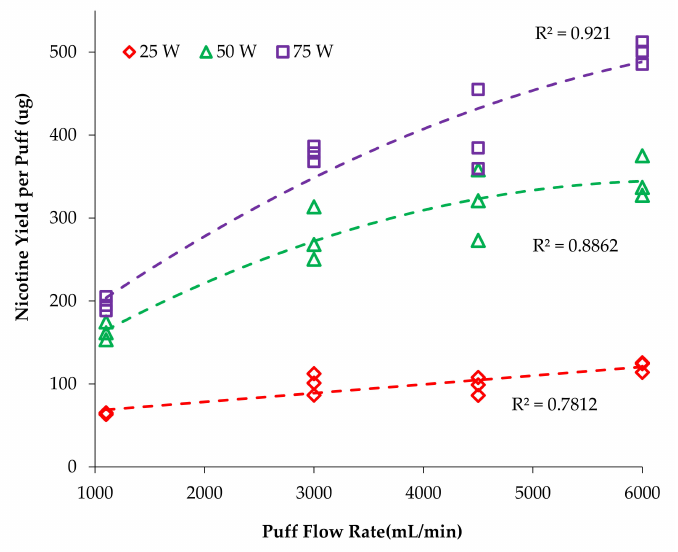
Figure 3. Effect of flow rate on nicotine yield at different power